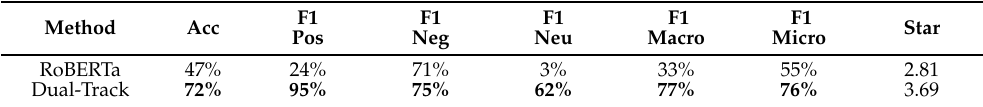
Table 8. Dual-track sentiment classification of LFSC-T (labeled